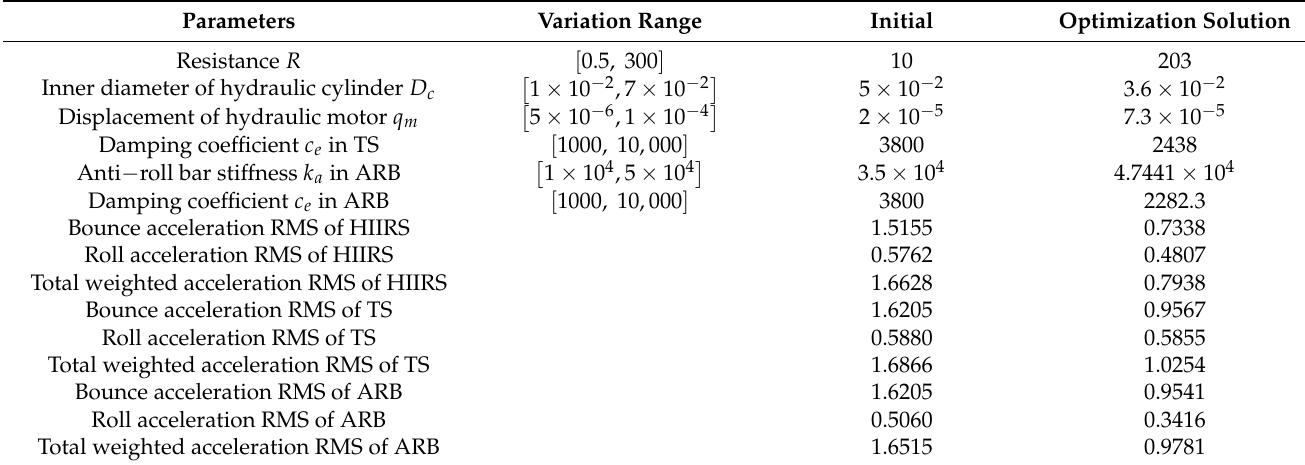
Table 5. Ride comfort optimization